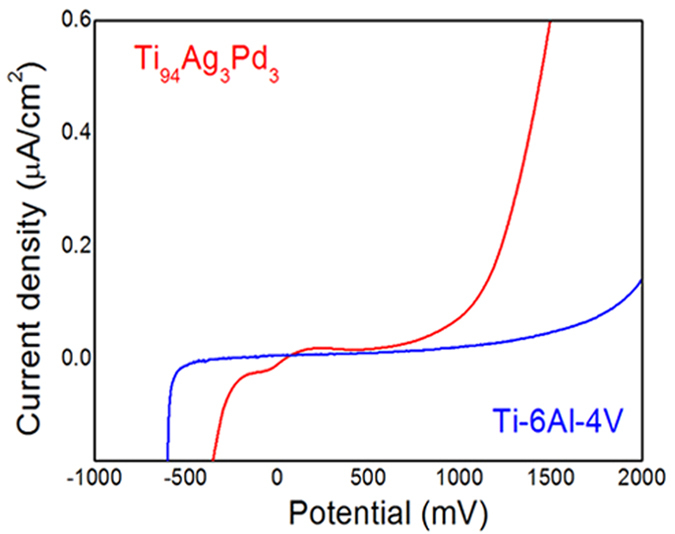
Potentiodynamic anodic polarization plot of Ti94Ag3Pd3 and Ti-6Al-4V, recorded at a scan rate of 2 mV/s.